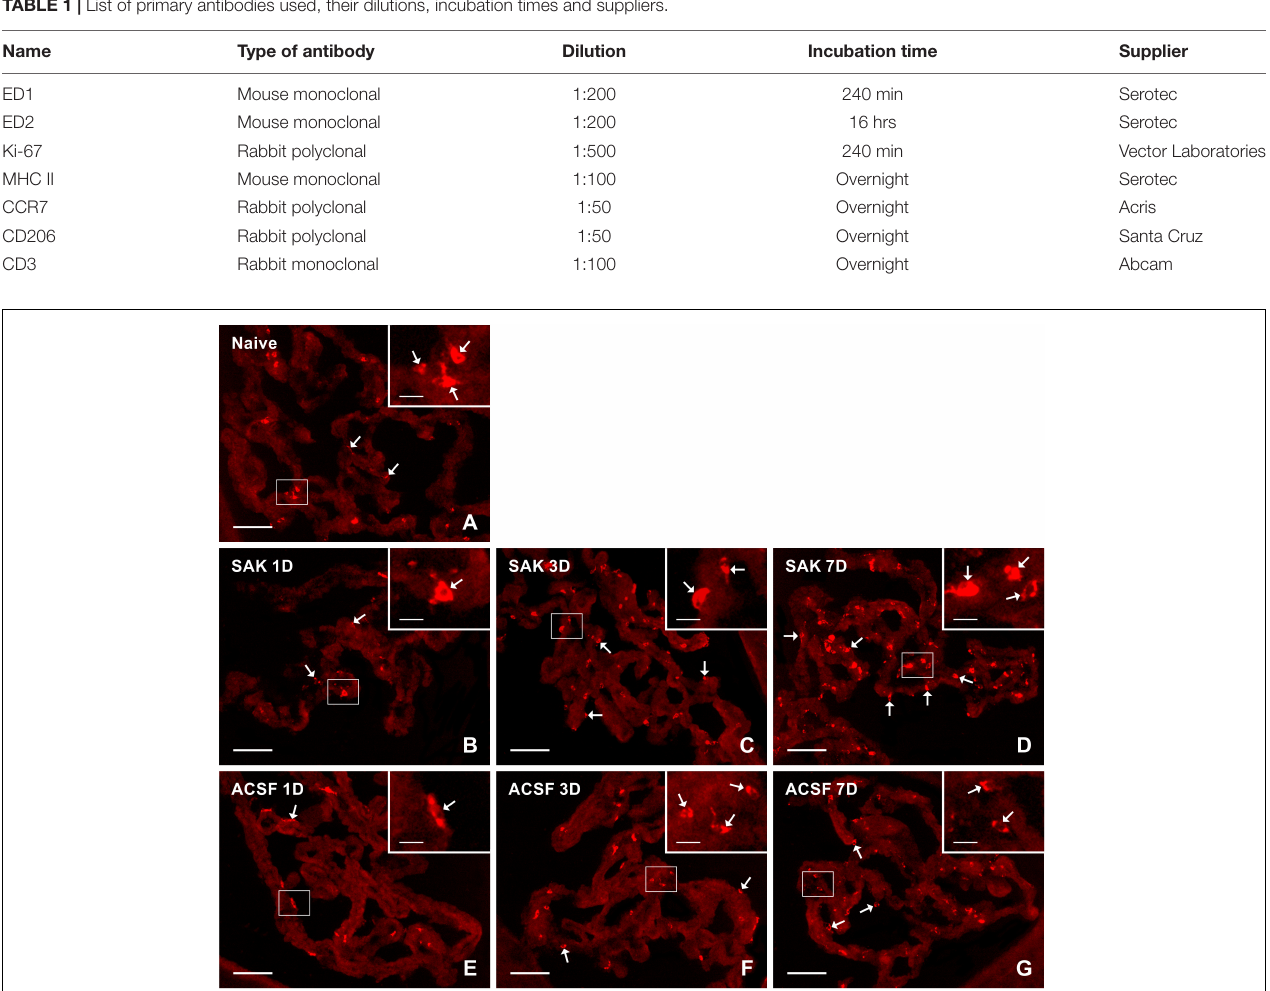
FIGURE 1 | Representative pictures showing results of immunostaining with ED1 antibody in cryostat sections of the CP from naïve (A) , SAH (B–D), and ACSF (E–G) rats at 1, 3 and 7 days (1D, 3D, and 7D) after operation. SAH induced an increase in the number of ED1+ cells 3 and 7 days after operation. Increased numbers of ED1+ cells were also found 3 and 7 days after application of ACSF. Arrows indicate ED1+ cells predominantly in the epiplexus position of the CP. Insets show a higher magnification of regions marked by the boxes. Scale bars = 80 µ m (main image); 10 µ m (insets).